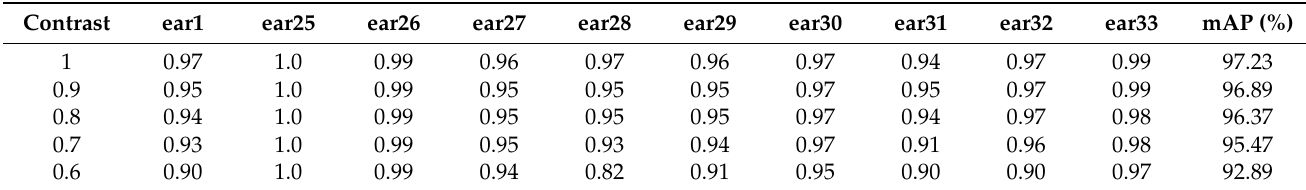
Table 13. Experimental results of mAP with different contrasts.